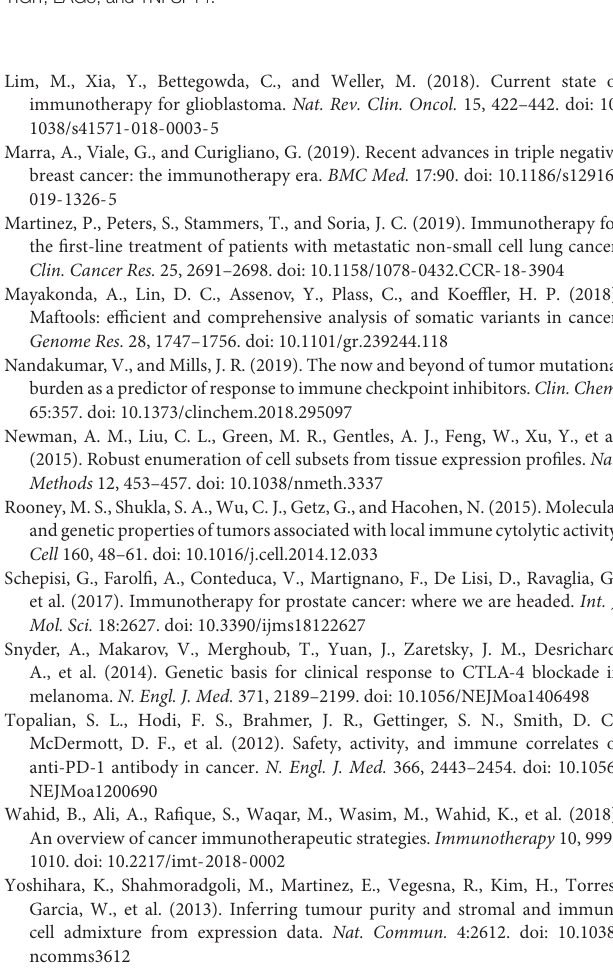
FIGURE S1 | (A) The co-occurrence and exclusive relationship of the high mutation genes. (B) Genecloud plot showed mutation information of genes in PRAD. The size of the font represents the frequency of the mutation. FIGURE S2 | (A) Unsupervised hierarchical clustering algorithm in PRAD patients. (B) The heatmap of the all immune cells in high, medium and low immune group. (C) The HLA expression in the high, medium and low immune group. (D–G) The expression of the tumor purity, estimate score, immune score and stromal score in three immune groups ( p value, *** < 0.001). FIGURE S3 | (A–F) Inhibitory receptor of CD8 + T cells expressed by tumor cells were expressed in the high, medium and low immune groups of prostate cancer ( p value, *** < 0.001). (G–L) There was a significant correlation between the CYT score and CD8 + T cell inhibitory receptor, including CTLA4, PD-1, TIM-3, BTLA, TIGIT, LAG3, and